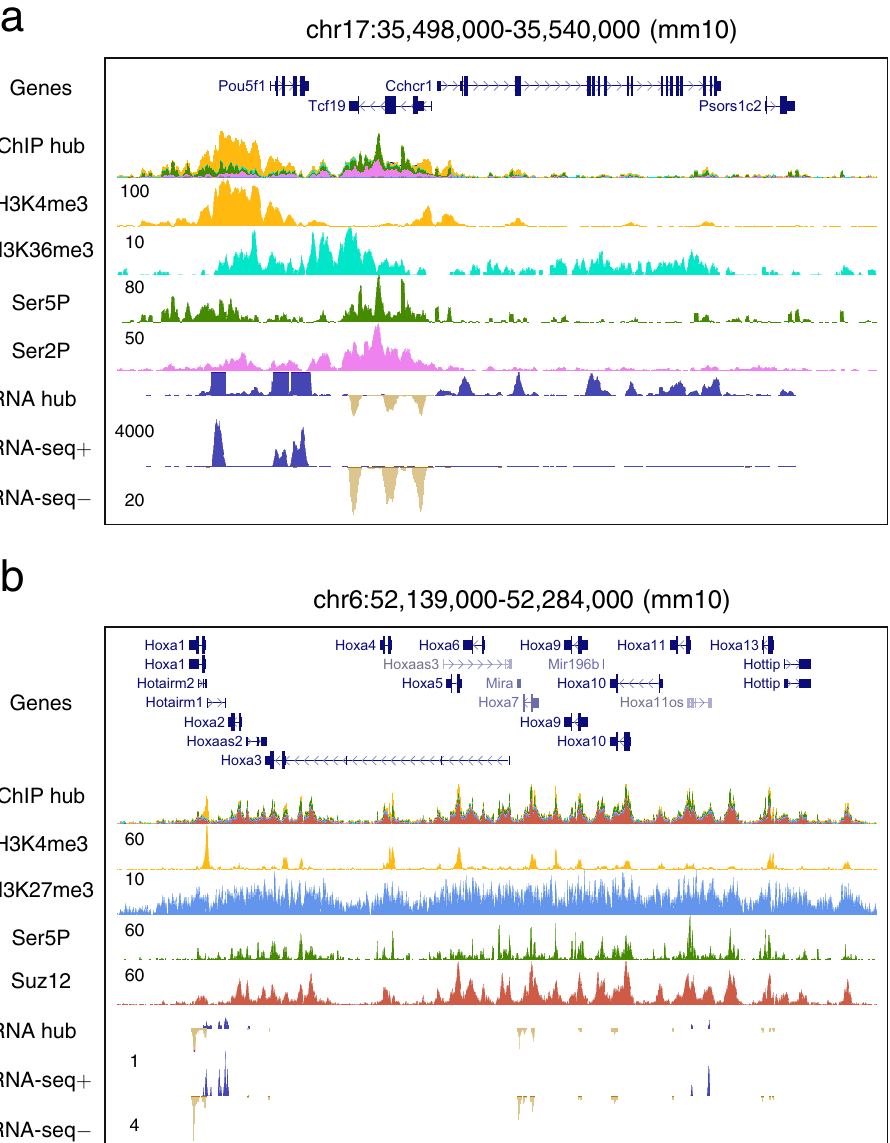
Figure 2. SeqCode ChIP-seq and RNA-seq profiles in mESCs for visualizing in genome browsers. (a) Actively transcribed region containing the Oct4/Pou5f1 pluripotency gene. (b) Region repressed for transcription by PcG proteins containing the HoxA complex. Raw data were retrieved from 32,33,38,75 . The SeqCode